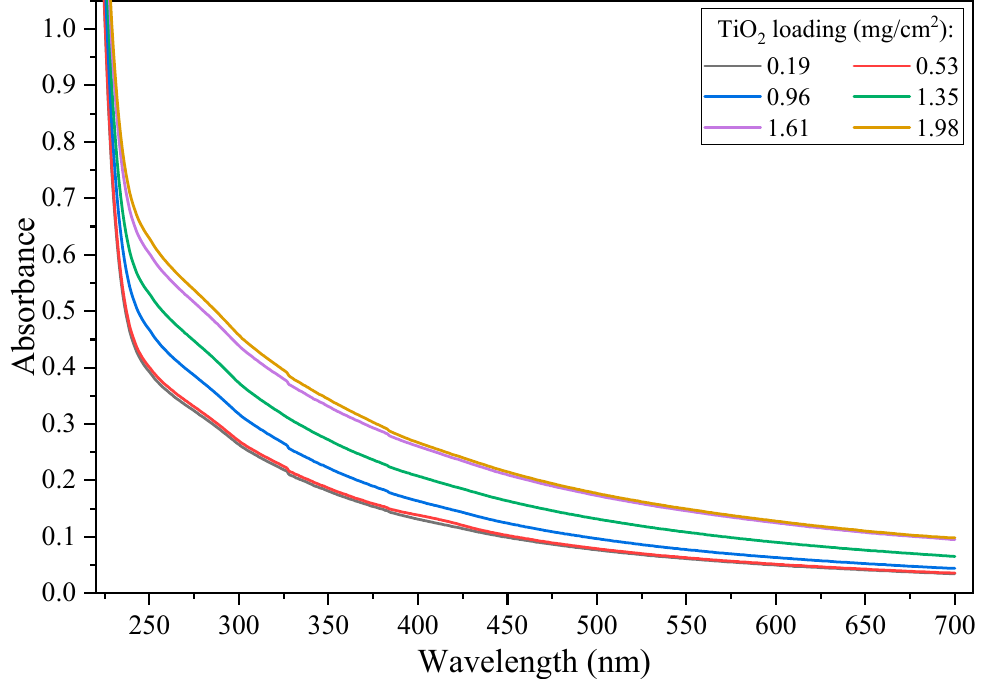
Figure 3. Absorbance spectra of the TiO 2 coated films at different catalyst loadings (0.19–1.98 mg TiO 2 /cm 2 ).